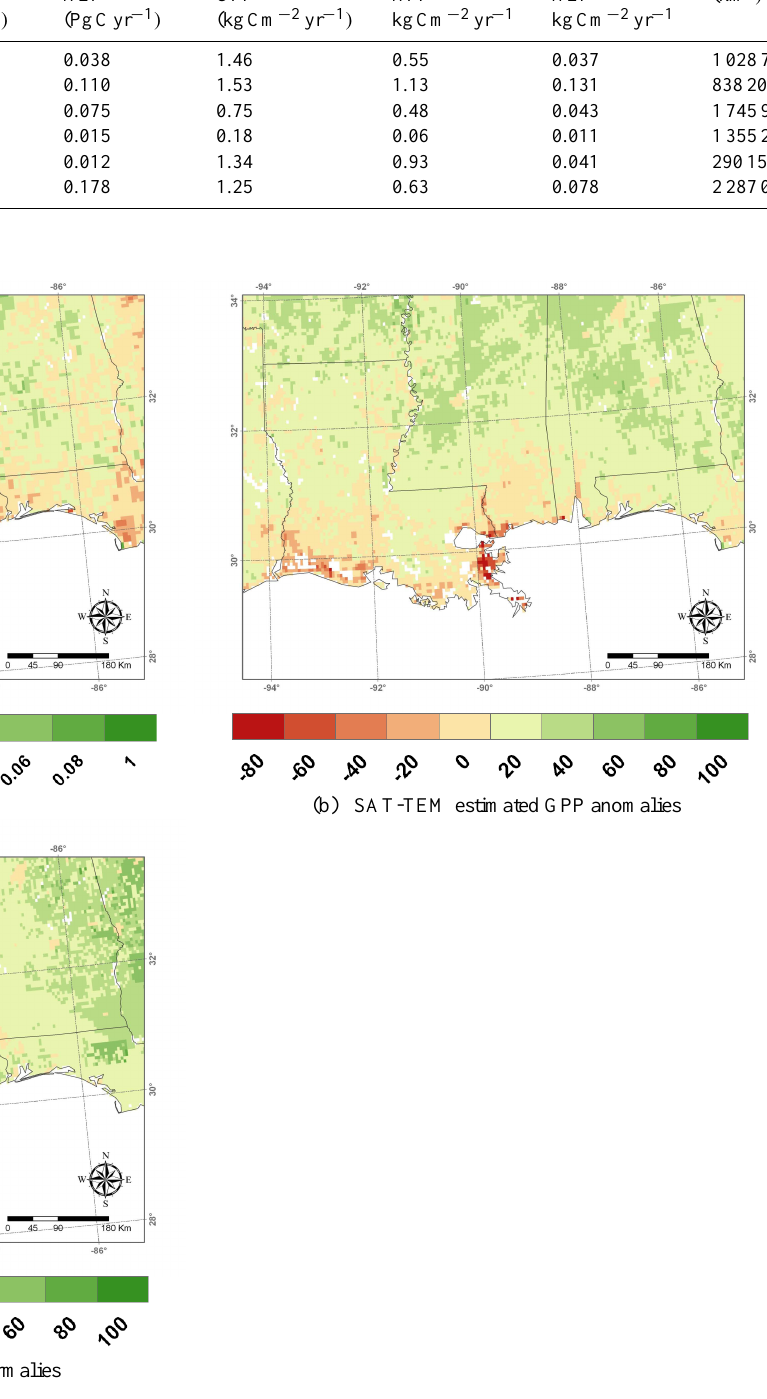
Fig. 8. Impacts of Hurricane Katrina on two-month-average EVI and estimated GPP. Units for GPP are gCm − 2 month − 1